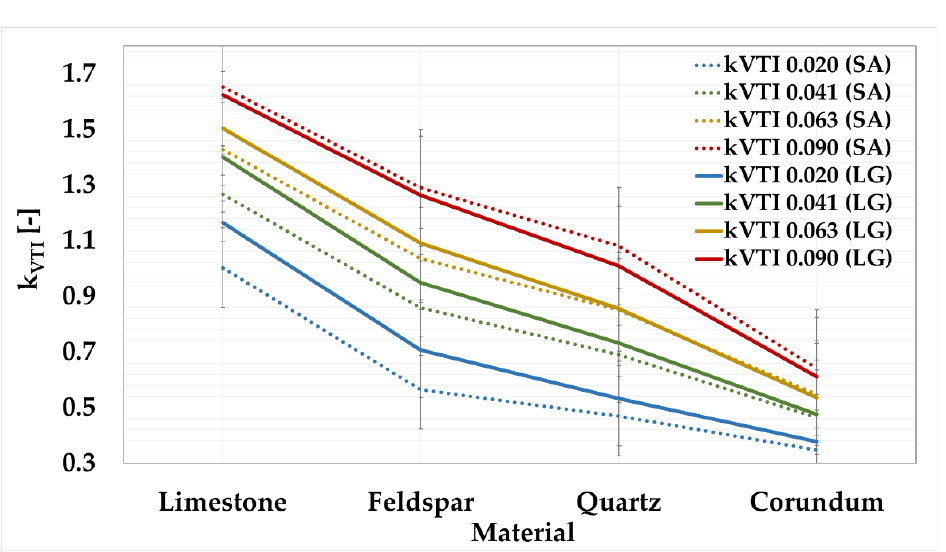
Figure 4. Comparison between k VTI from sieve analysis to k VTI from laser granulometry.